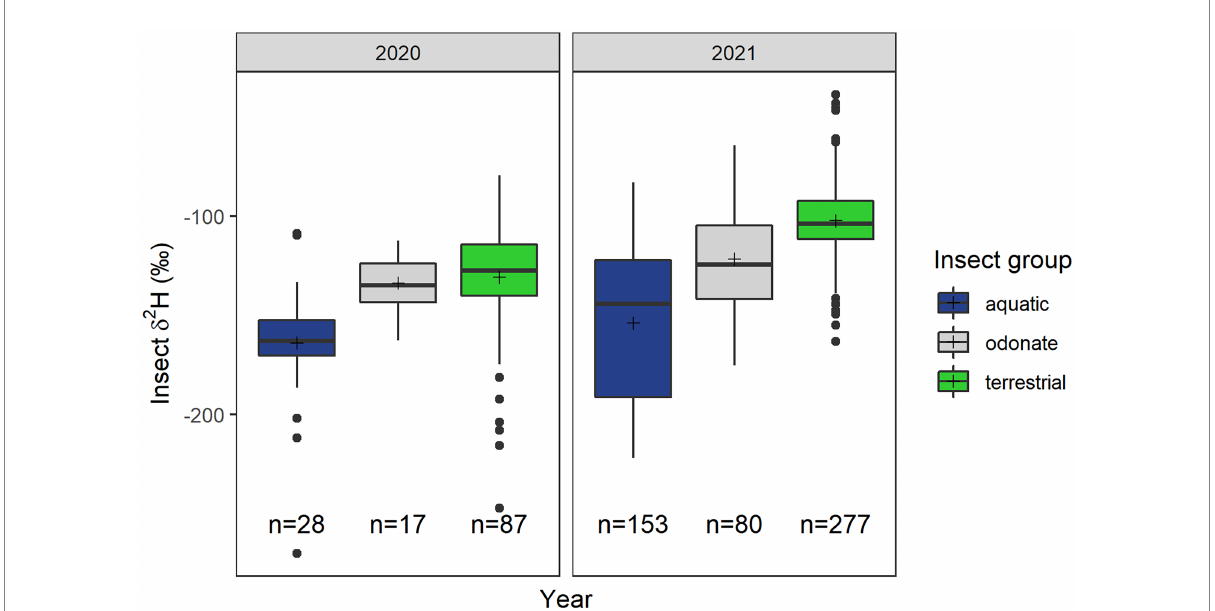
FIGURE 4 Boxplot showing insect δ 2 H values (‰) from different insect groups. These groups include smaller aquatic insects, odonates, and terrestrial insects sampled in the study area. Sample sizes are as shown on the plot and means are represented by (+) symbol. Refer to Supplementary material for data of insects included in each